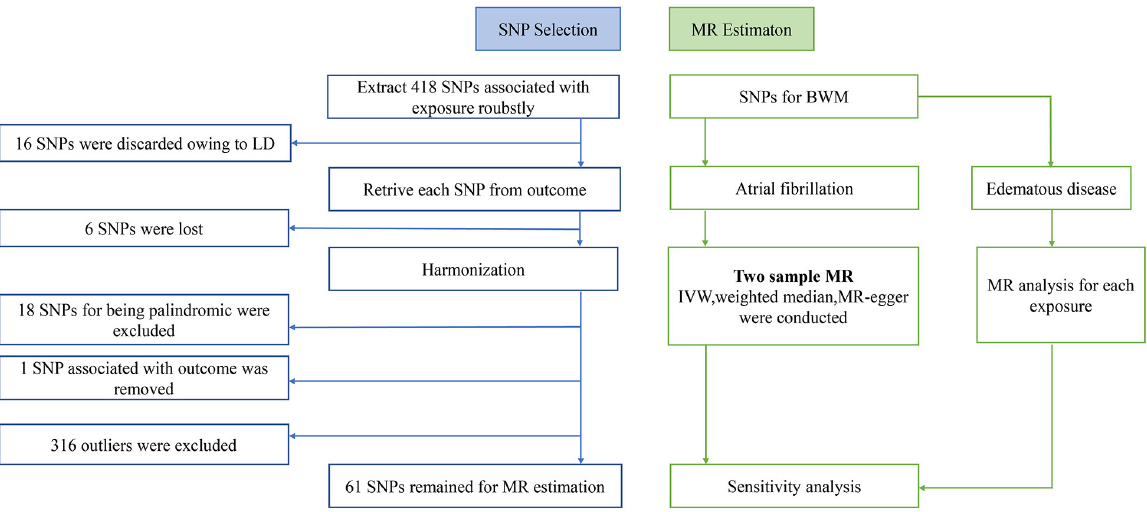
Figure 1. Flowchart of the present MR flame. SNP, single nucleotide polymorphism; BWM, body water mass; MR, Mendelian randomization; LD, linkage disequilibrium.